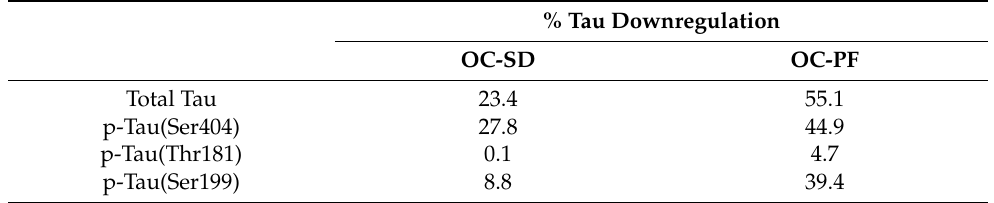
Table 1. Western blotting-based quantitative downregulation of total and selected phosphorylated tau levels in 5xFAD female mouse brains in response to 4-month oral treatments by OC